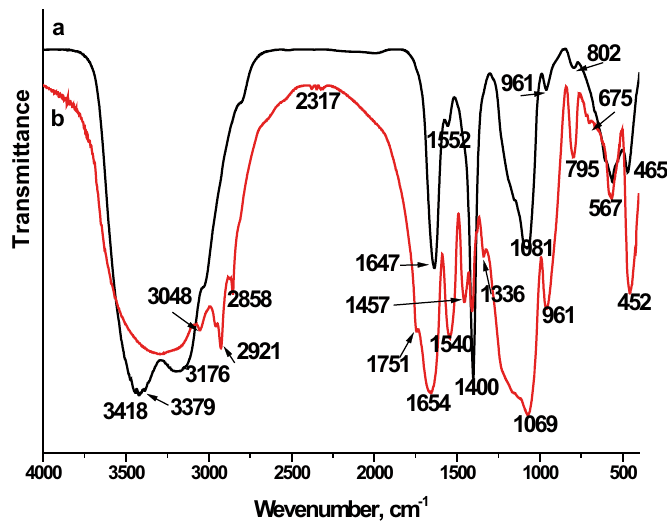
Figure 4. FTIR spectra of C-CPS/W hybrids with different quantity of C and CPS/W- 25:75 wt.% (a) and 75:25 wt.% (b), after 3 days immersion in 1.5 SBF